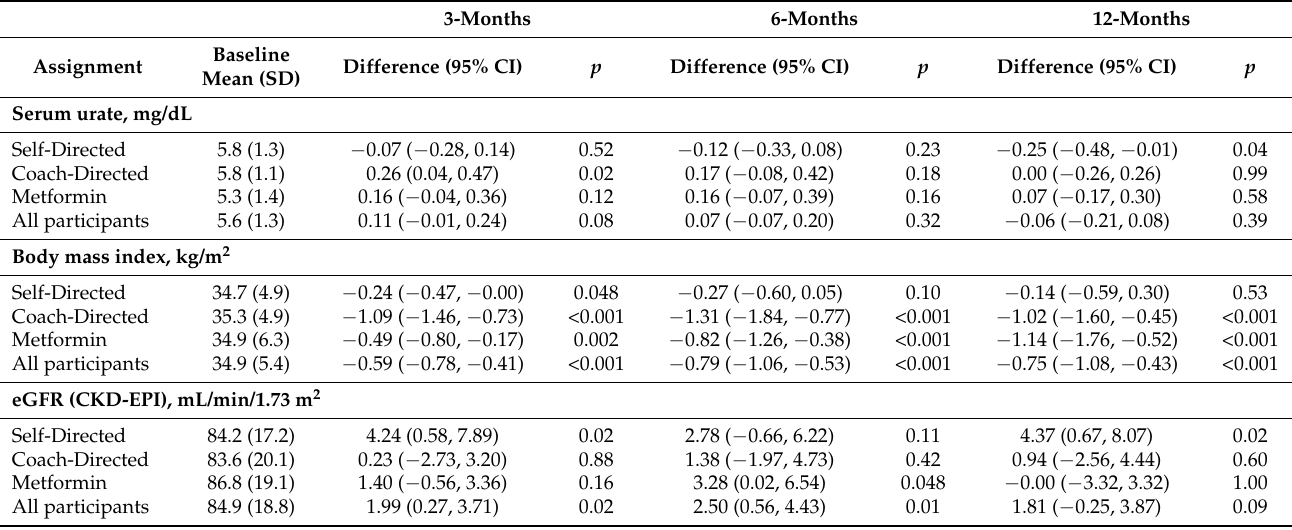
Table 2. Change in serum urate level (mg/dL) and body mass index (kg/m 2 ) in SPIRIT compared to baseline at 3 months, 6 months, and 12 months, by randomized arm and among all